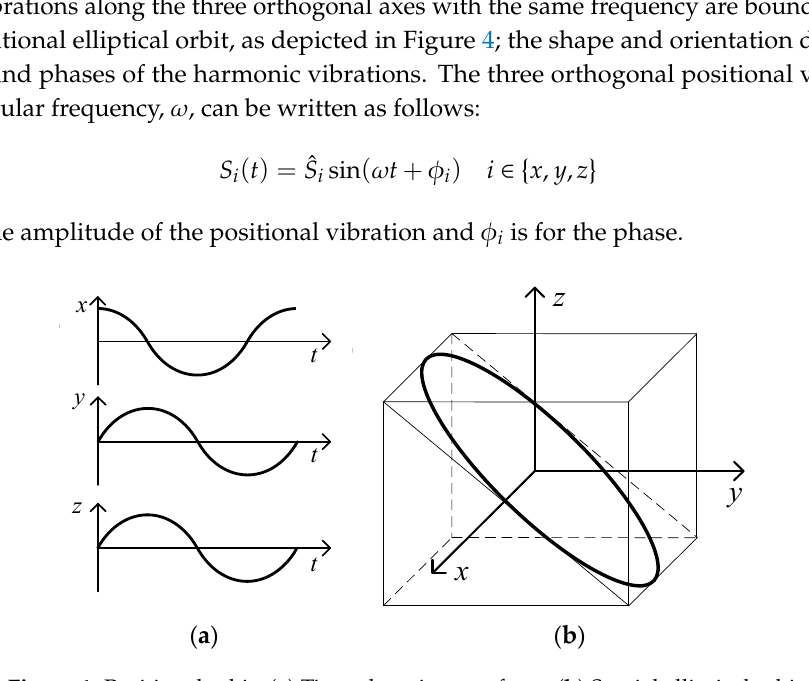
Figure 4. Positional orbit. ( a ) Time–domain waveform; ( b ) Spatial elliptical orbit.